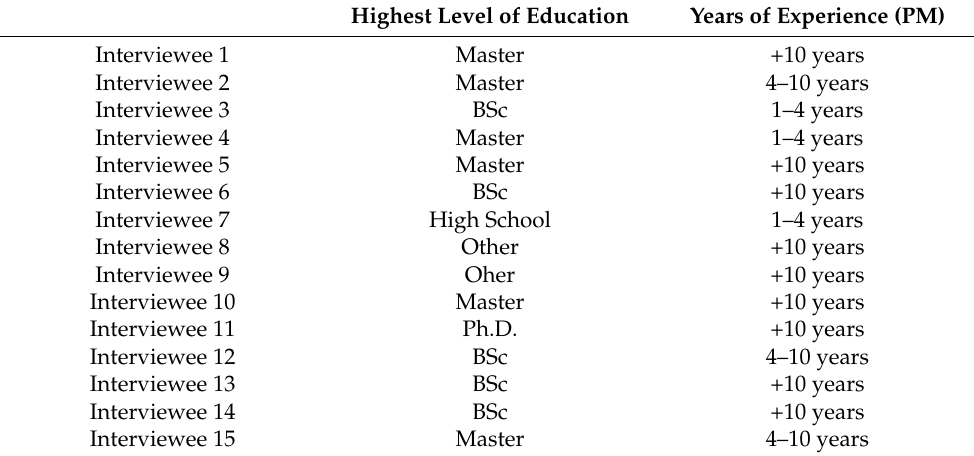
Table 1. Interviewees’ level of education and years of